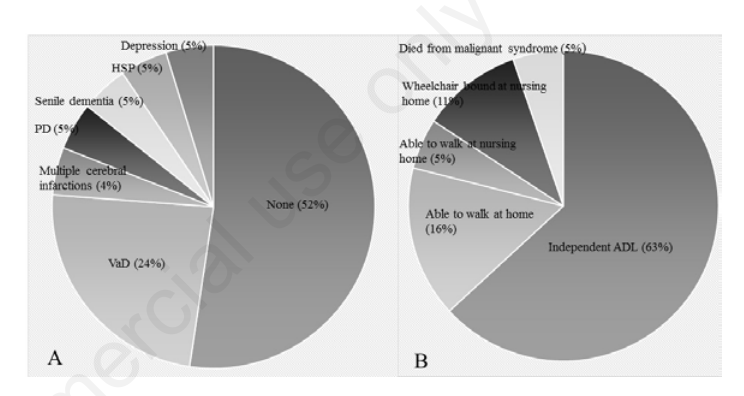
Figure 2. All causative drugs were prescribed in non-neurological departments. Drugs were prescribed in 8 cases (38.1%) in psychiatric and in 13 cases (61.9%) in non-psychiatric departments, which included prescriptions from seven general practitioners, three general hospital surgeons, two general hospital internal medicine physicians, and one nursing home physician. In total, over half of the causative drugs were prescribed in non-psychiatric departments (A). The main reasons for prescribing were listed as depression (29%), psychi- atric symptoms (33%), abdominal discomfort (19%), and unknown (19%) (B).